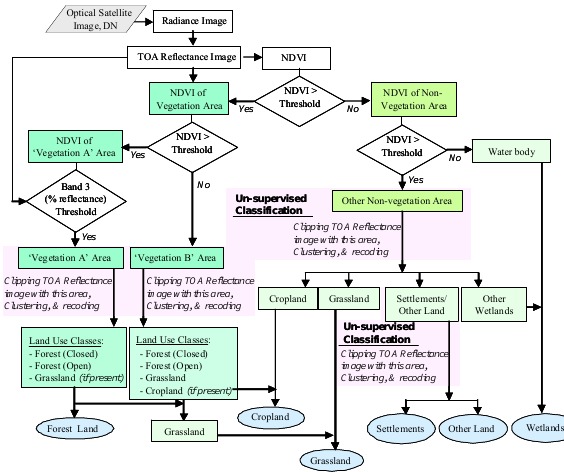
Figure 3. General Workflow of LC